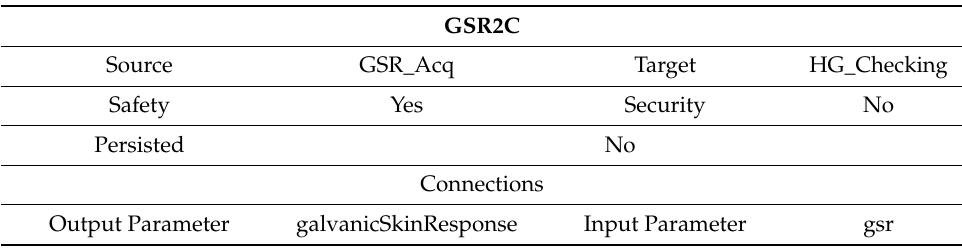
Table 3. Characterization of the GSR2C connector.